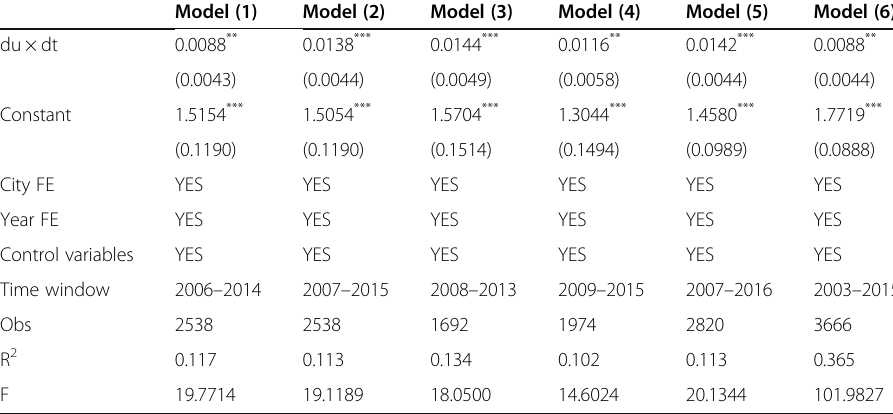
Table 4 Results of robustness test (with changed time widths) Model